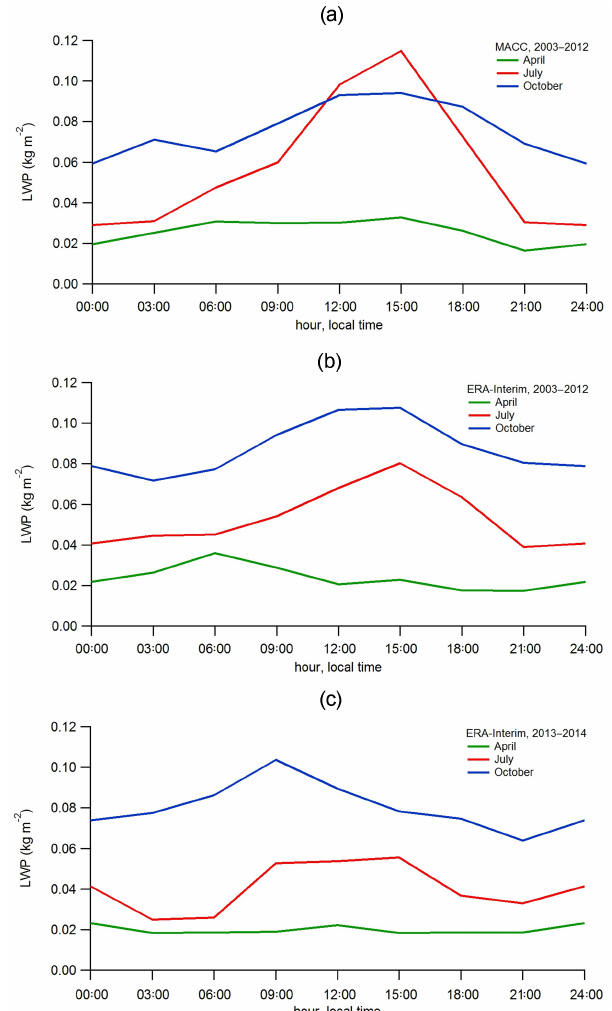
Figure B1. The average diurnal LWP variations over St Peters- burg in April, July and October, derived from the data of reanaly- sis: MACC 2003–2012 (a) , ERA-Interim 2003–2012 (b) and ERA- Interim 2013-2014 (c)